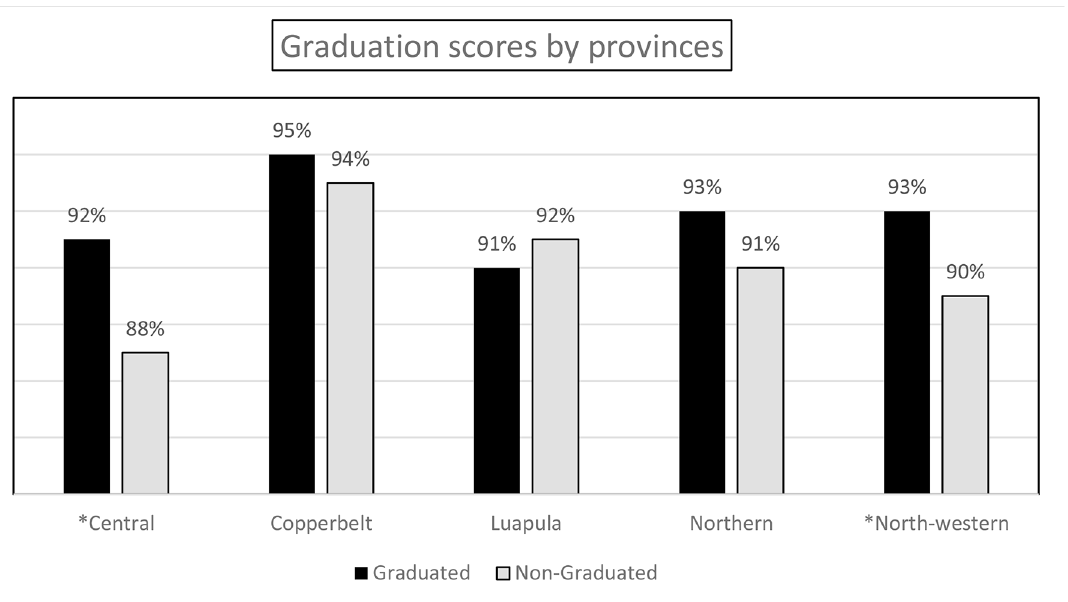
Fig 3. Graduation scores by province in graduated and non-graduated districts. Central OR 1.61 (95%CI: 1.31 – 1.97), P < 0.001; Copperbelt OR 1.12 (95%CI: 0.90 – 1.39), P = 0.279; Luapula OR 0.87 (95%CI (0.66 – 1.15), P = 0.322; Northern OR 1.33 (95%CI (1.00 – 1.78), P = 0.052; North-western OR 1.45 (95%CI (1.07 – 1.96), P =